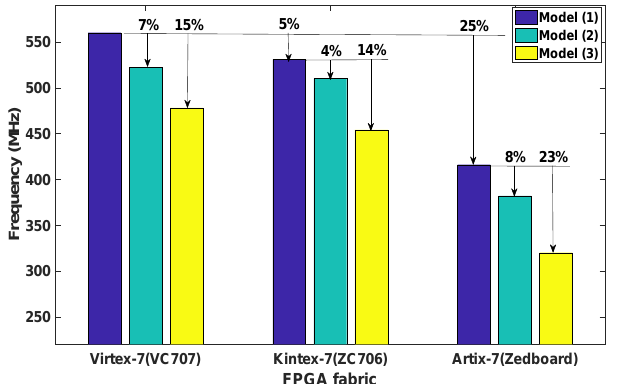
Figure 7. Impact of the various datapath models 1 (cid:13) , 2 (cid:13) , 3 (cid:13) on f max across Xilinx Artix-7, Kintex-7 and Virtex-7 FPGA